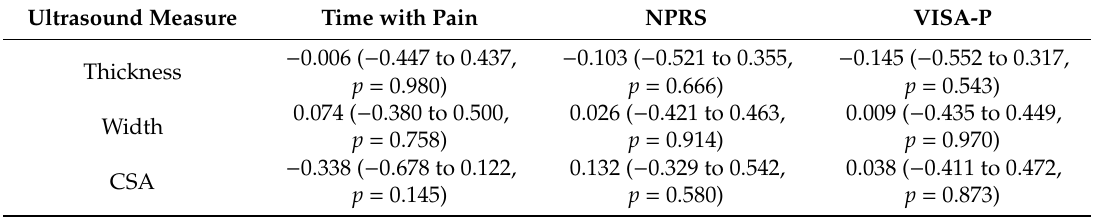
Table 2. Spearman (95% confidence interval) correlation test between ultrasound gross measures and clinical features in non-elite sport players with unilateral patellar tendinopathy. Ultrasound